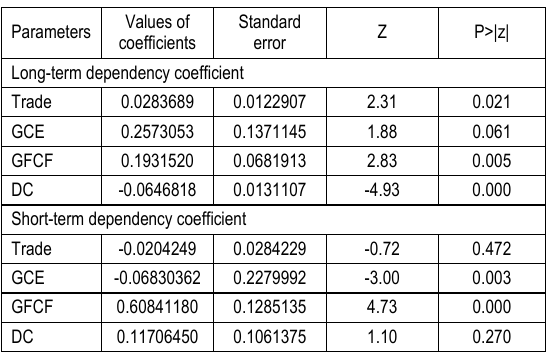
Table 14. The results of PMG approach to determining short-term and long-term coefficients of dependency between imbalances in the movement of financial resources (according to DC